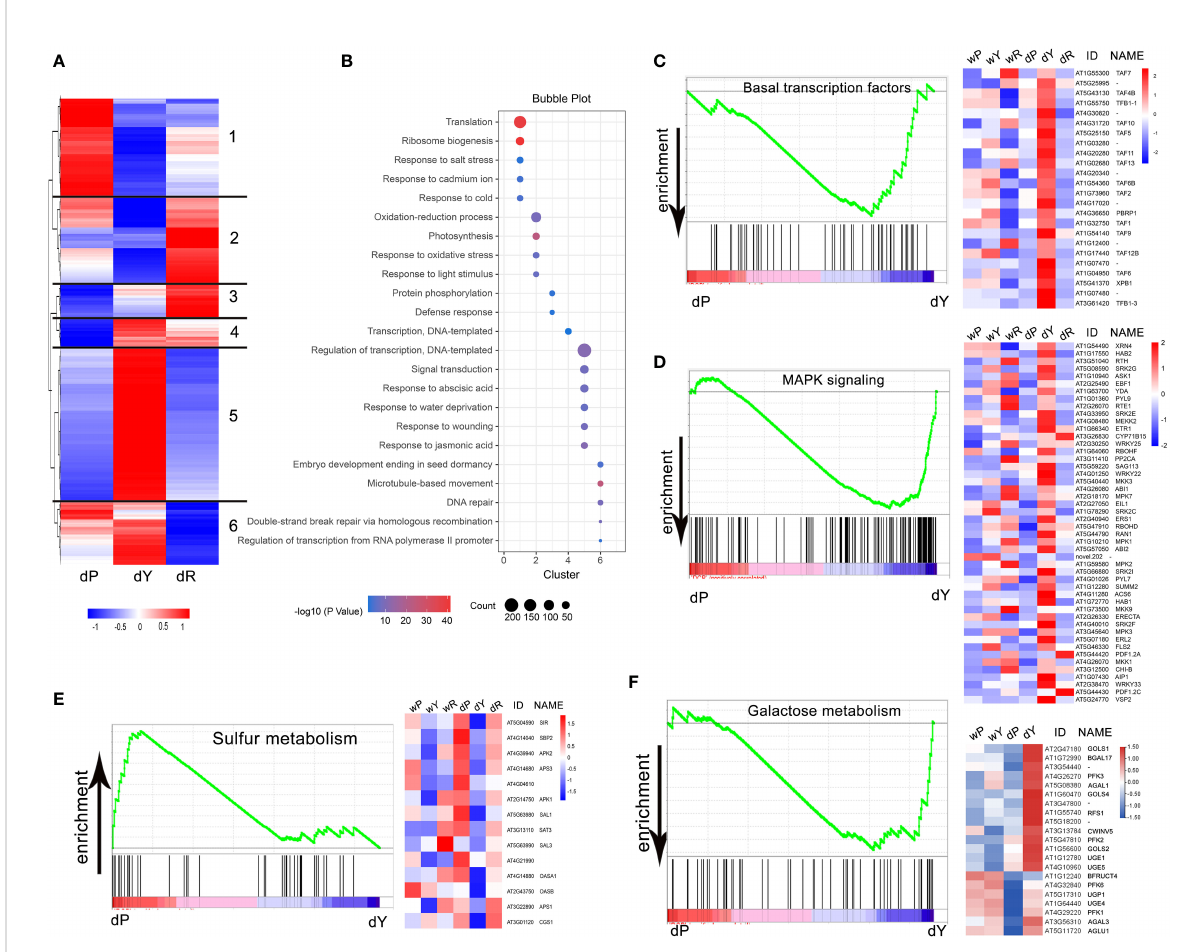
FIGURE 5 Enrichment analysis of differentially expressed genes in P, Y, and R: (A) Heatmap representation of 5517 genes differentially regulated in P, Y, and R (FC > 2, adjusted P value < 0.01). Six clusters of co-regulated genes are indicated. Color pattern represents row Z-score; (B) Bubble chart showing results of Gene Ontology (GO) enrichment analysis. Bubble size indicates number of genes associated with each term. Bubble color indicates − log 10 ( P value); (C, D, F) GSEA plots for pathways enriched in dY compared to dP (FDR < 25%). Selected gene expressions are presented in heatmaps, the gene expressions in R are also shown in (C, D) ; (E) GSEA plot for pathways enriched in dP compared to dY (FDR < 25%), selected gene expressions are presented in heatmaps, the gene expressions in R are also